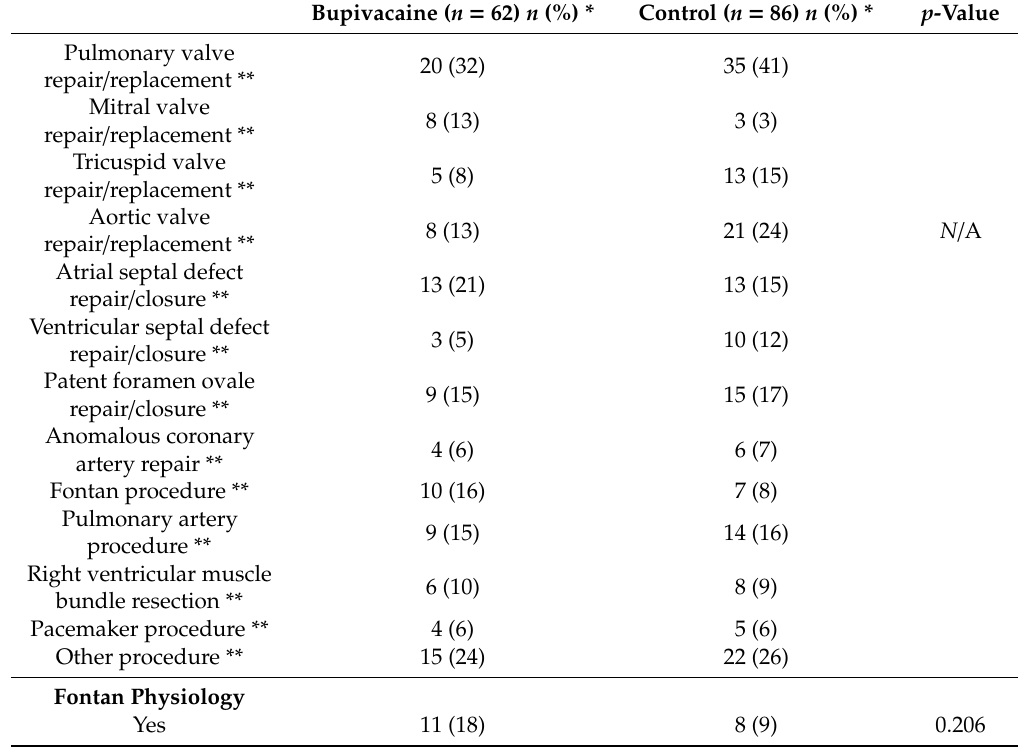
Table 2. Patient clinical information (cardiac surgical diagnosis).